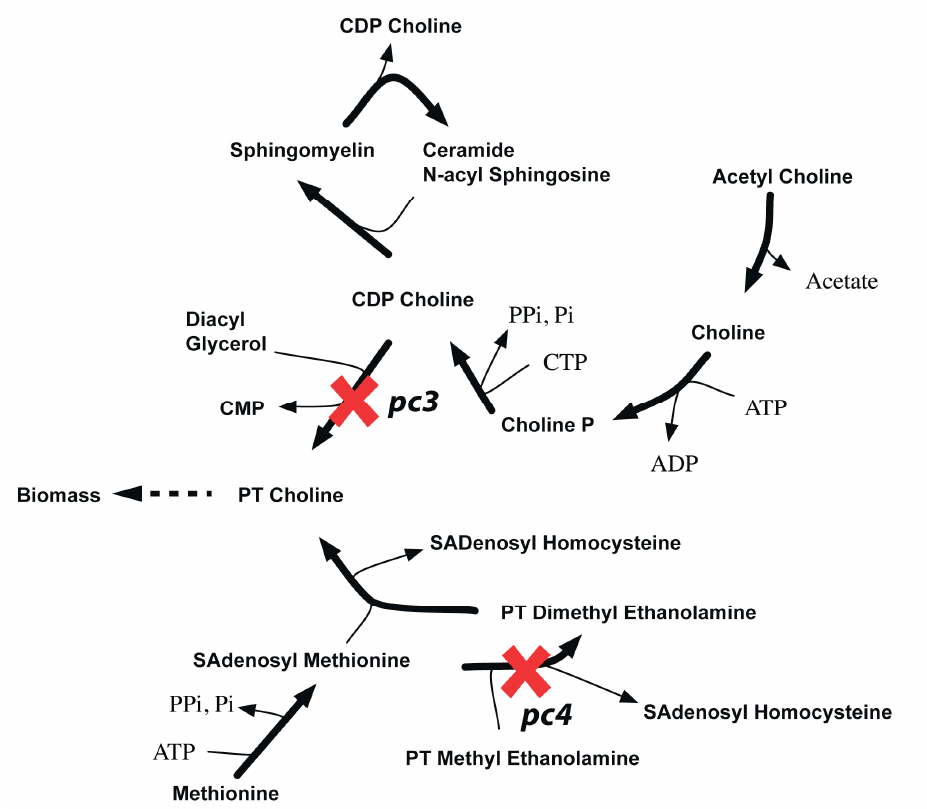
Figure 14. pc3-pc4 synthetic lethality. It shows how in silico removal of pc3 and pc4 prevents synthesis of phosphatidyl